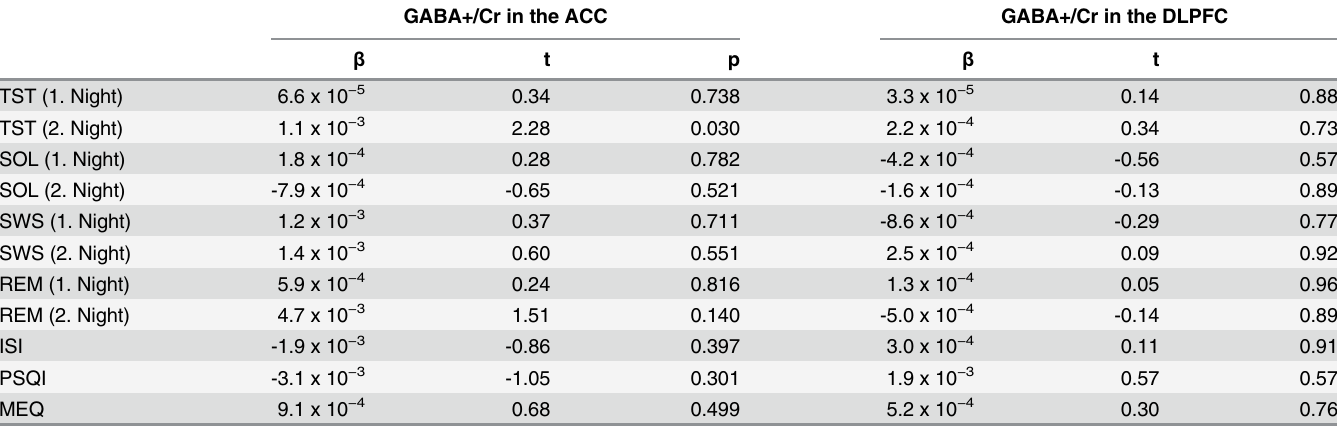
Table 3. Results from the analysis of the relationship between polysomnographic parameters and GABA+/Cr in the ACC and DLPFC. GABA+/Cr in the ACC GABA+/Cr in the DLPFC